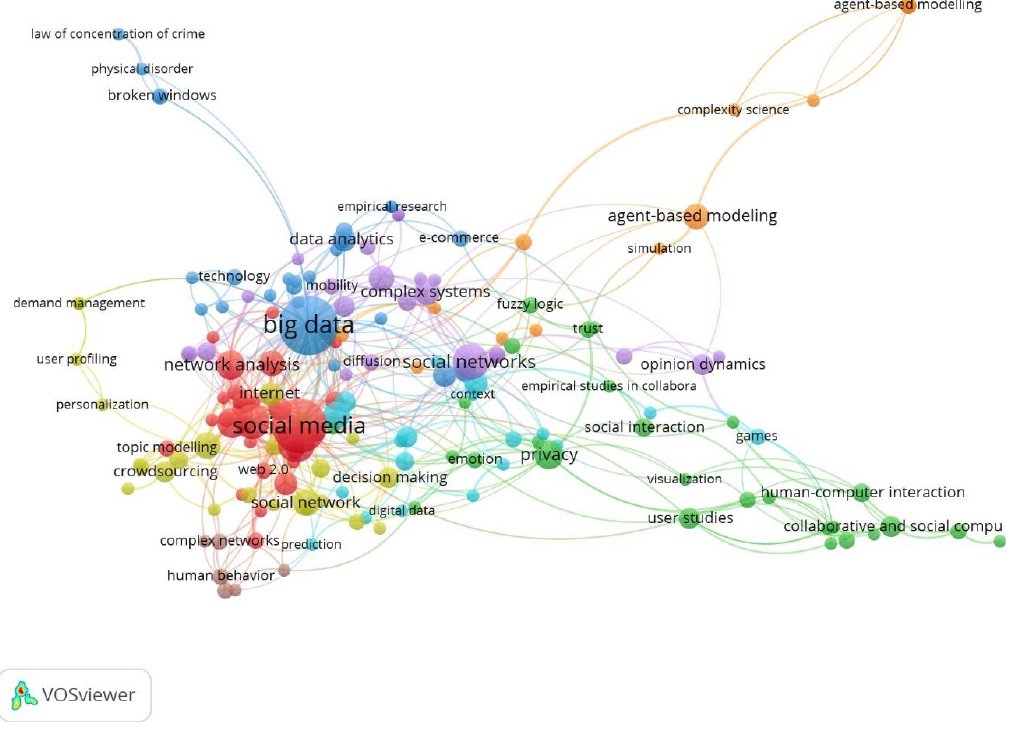
Figure 9. Author Keywords of CSS, based on WoS, CSS dataset.